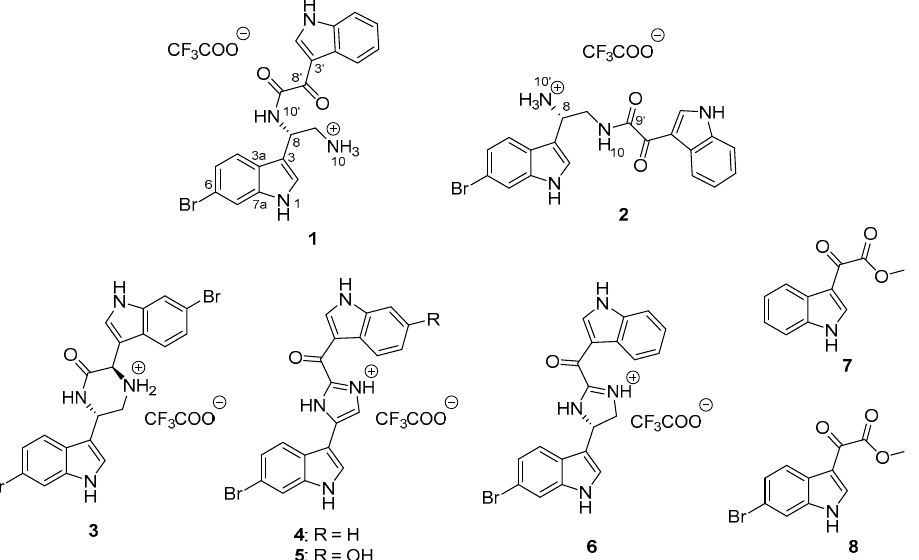
Figure 1. New calcicamides A and B ( 1 – 2 ) and known indole alkaloids, trans -3,4-dihydrohamacanthin A ( 3 ), 6-bromodeoxytopsentin ( 4 ), 6-bromotopsentin ( 5 ), spongotine A ( 6 ), 2-(1 H -indol-3-yl)-2- oxoacetate methyl ester ( 7 ) and 2-(6-bromo-1 H -indol-3-yl)-2-oxoacetate methyl ester ( 8 ) from Spongosorites calcicola